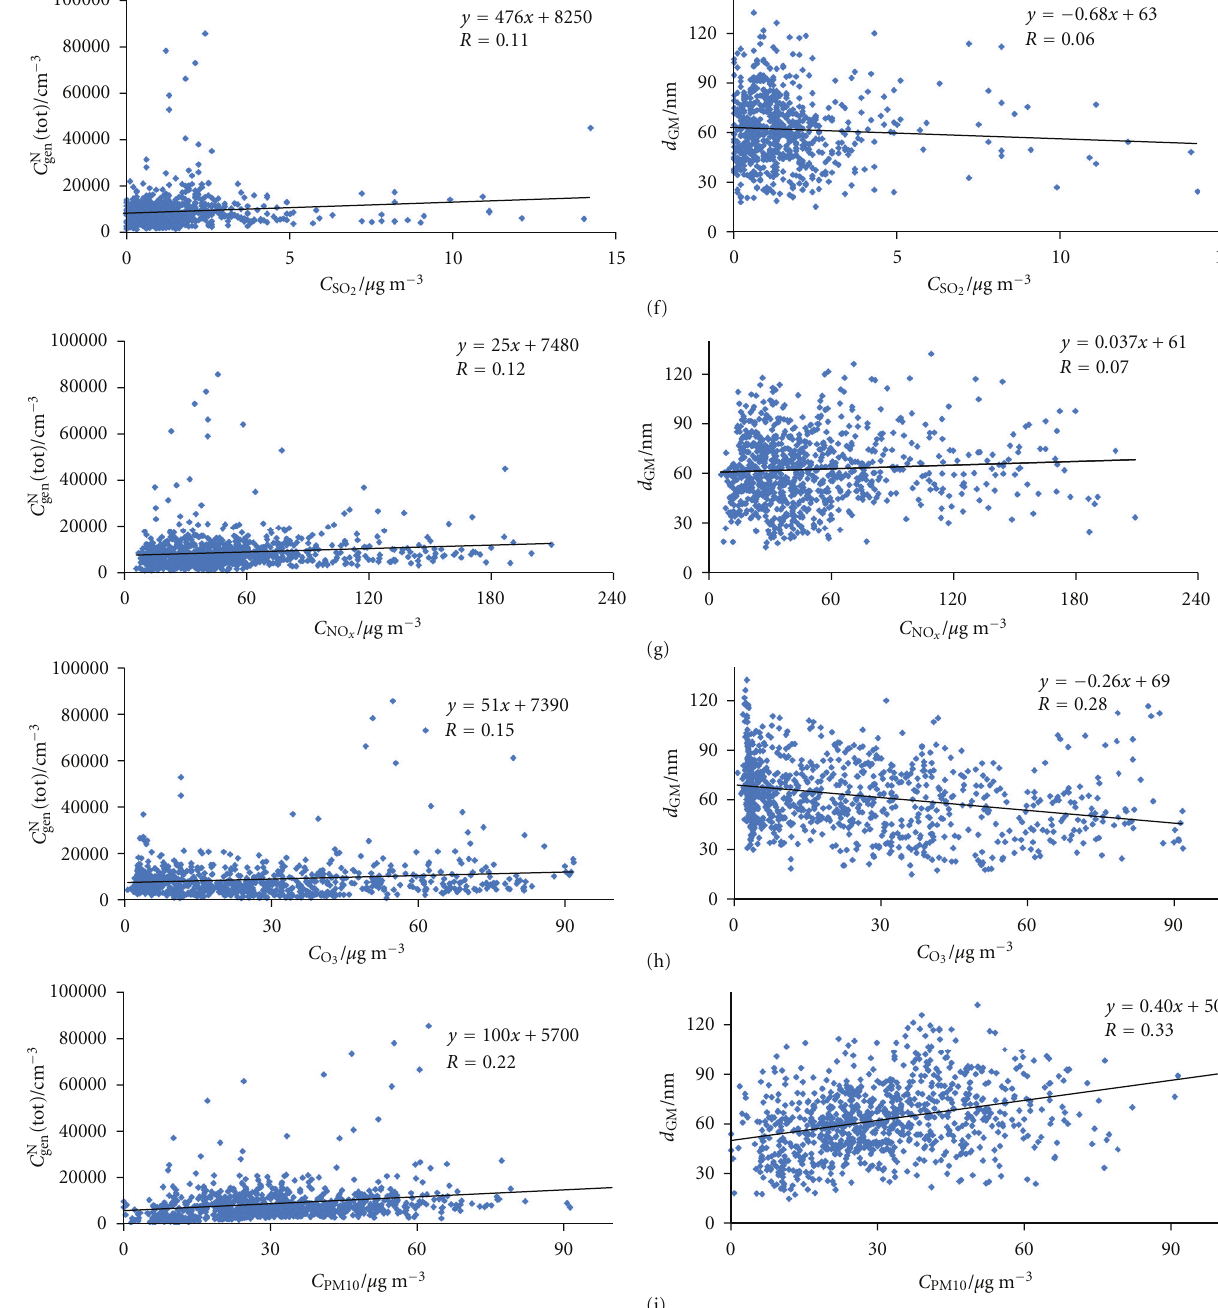
Figure 5: Correlations of the following relationships in outdoor air for the period October 6–26, 2010: (a) C N C N (tot)– H rel and d GM – H rel , (c) C N gen